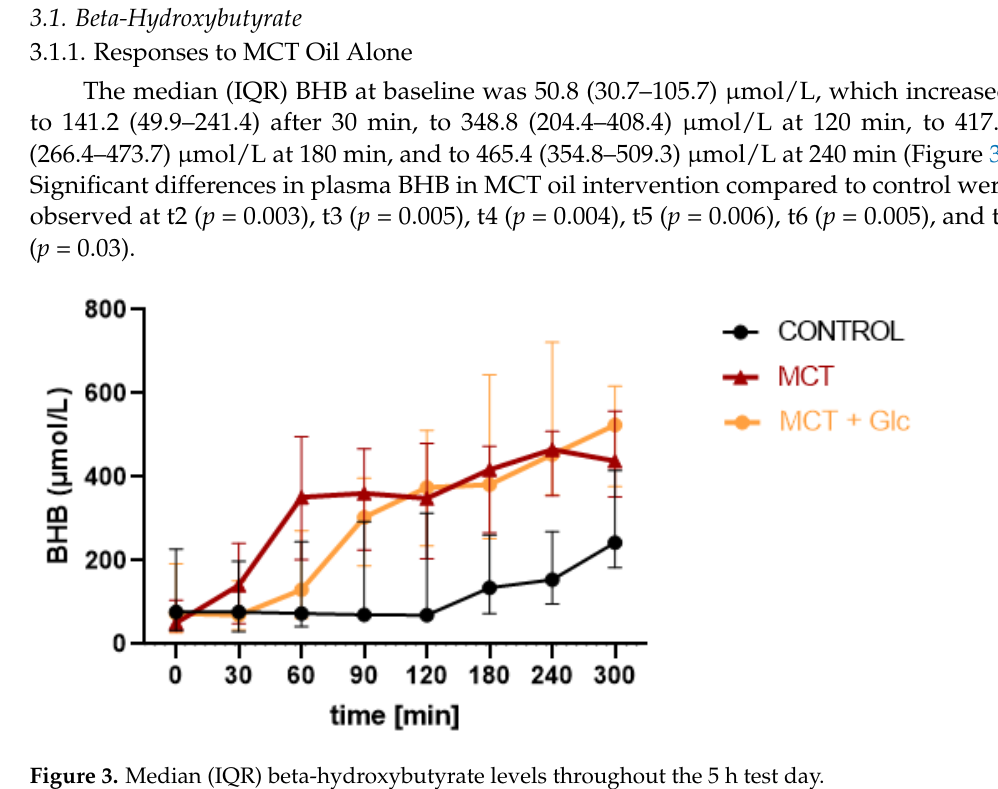
Figure 3. Median (IQR) beta-hydroxybutyrate levels throughout the 5 h test day.